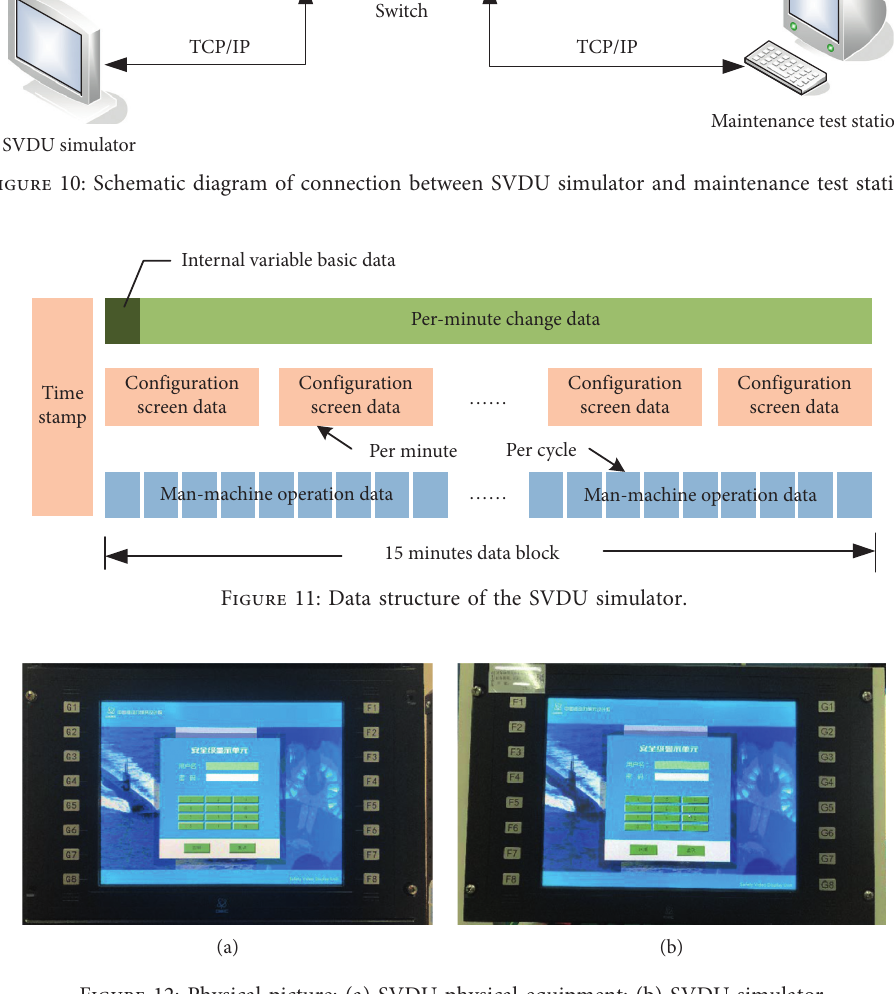
Figure 12: Physical picture: (a) SVDU physical equipment; (b) SVDU